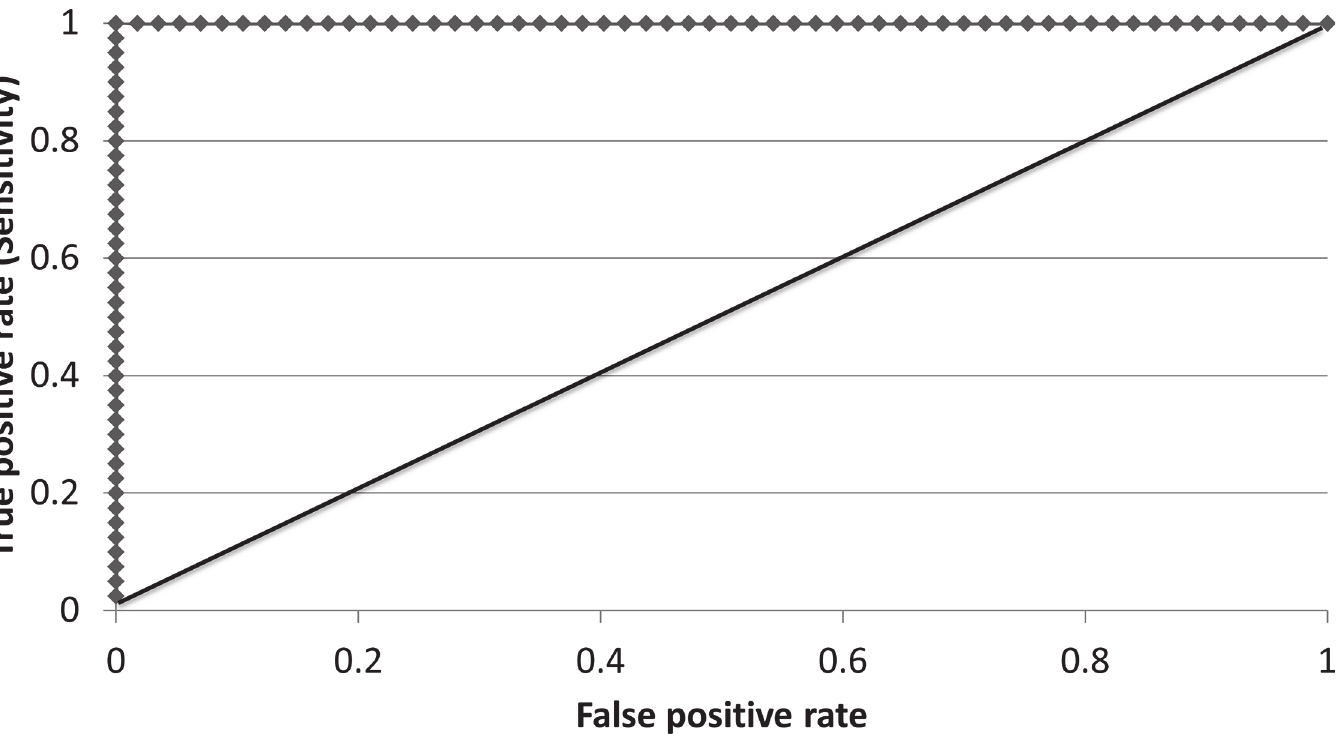
Fig 2. Receiver operating characteristic (ROC) curve analysis 19-question PlantRight plant risk evaluation (PRE)